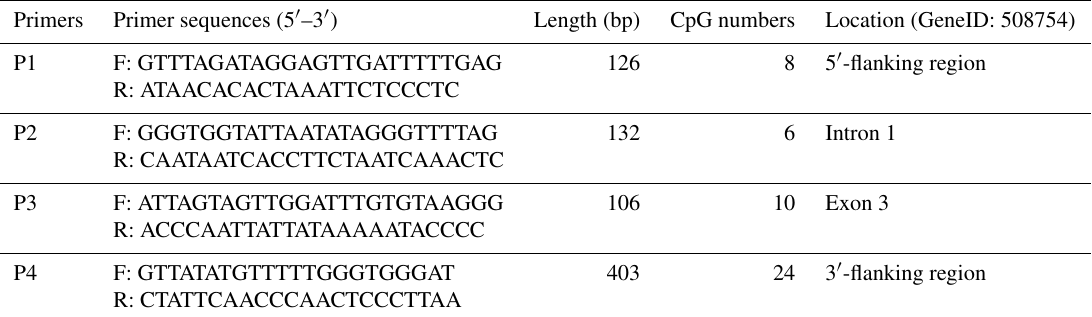
Table 2. Primers used for PCR amplification. Primers Primer sequences (5 (cid:48) –3 (cid:48)